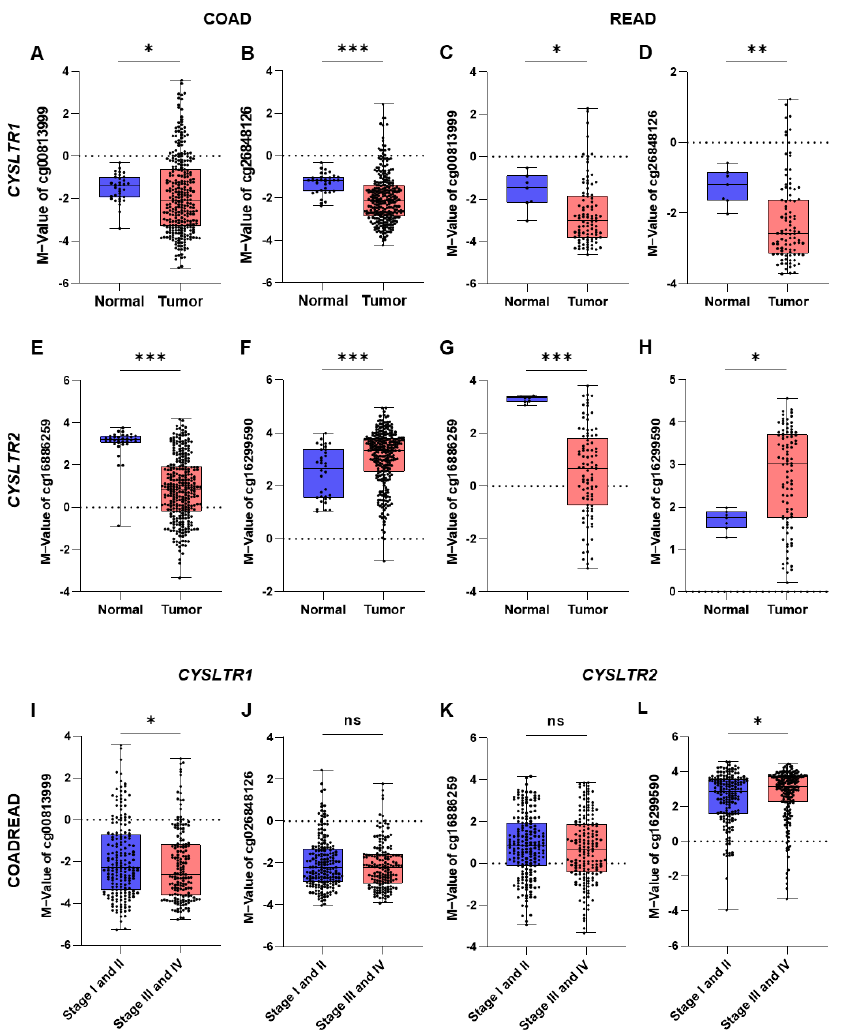
Figure 2. Box-and-whisker plots of the M − value distribution for CpG probes between normal and tumor samples in the TCGA − COADREAD cohort. The M − value distribution between normal and tumor samples for cg00813999 ( A , C ) and cg26848126 ( B , D ) in colon (COAD) and rectal (READ) cancer. The M − value distribution between normal and tumor samples for cg16886259 ( E , G ) and cg16299590 ( F , H ) in colon (COAD) and rectal (READ) cancer. The M − value distribution between early and advanced stages for cg00813999 ( I ), cg26848126 ( J ), cg16886259 ( K ) and cg16299590 ( L ) in colorectal (COADREAD) cancer. * p < 0.05; ** p < 0.01; *** p < 0.001; ns = not There was a significant correlation between the mRNA expression of the EMT (epi- thelial – mesenchymal transition) markers CDH1 (E-cadherin) and VIM (vimentin) and high CYSLTR1 gene expression in tumor samples. CDH1 and VIM gene expression were significantly reduced and increased, respectively, in tumor samples with high CYSLTR1 gene expression (Figure 3A). However, the opposite was true for CYSLTR2 gene expres- sion (Figure 3B). CDH1 and VIM gene expression were significantly decreased and in- creased in the low M-value groups for both CpG probes of CYSLTR1 (cg00813999 and cd26848126, Figure 3C,D). Interestingly, the opposite result was obtained for both CpG